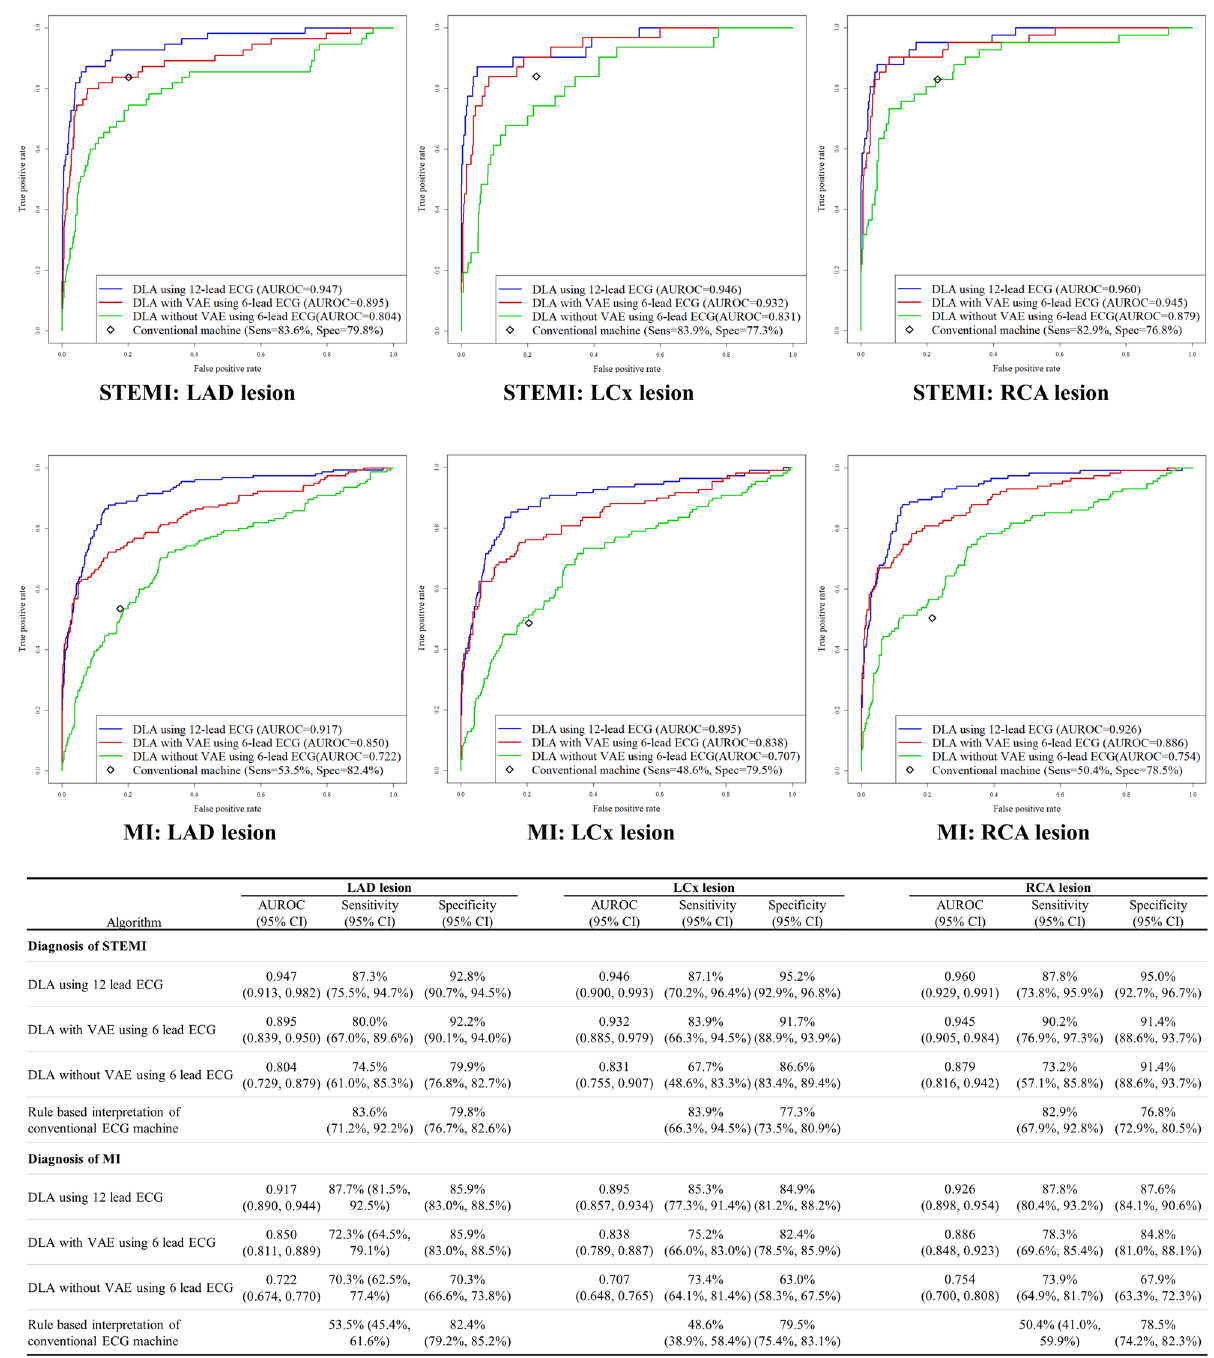
Figure 3. Performances of artificial intelligence algorithms for detecting MI by coronary artery lesion. AE auto-encoder, AUC area under the receiver operating characteristics curve, DLA deep learning-based algorithm, ECG electrocardiography, LAD left anterior descending coronary artery, LCx left circumflex coronary artery, MI myocardial infarction, NPV negative predictive value, Sens sensitivity, Spec specificity, STEMI ST-segment elevation myocardial infarction, PPV positive predictive value, RCA right coronary artery. These performances were calculated by using the operating point at Youden J statistics of development